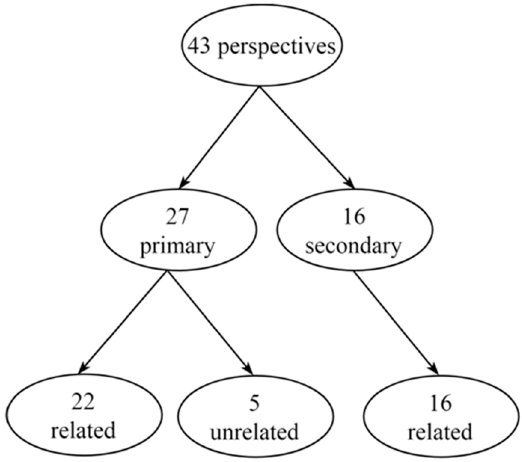
Figure 4. Classification of the 43 perspectives.